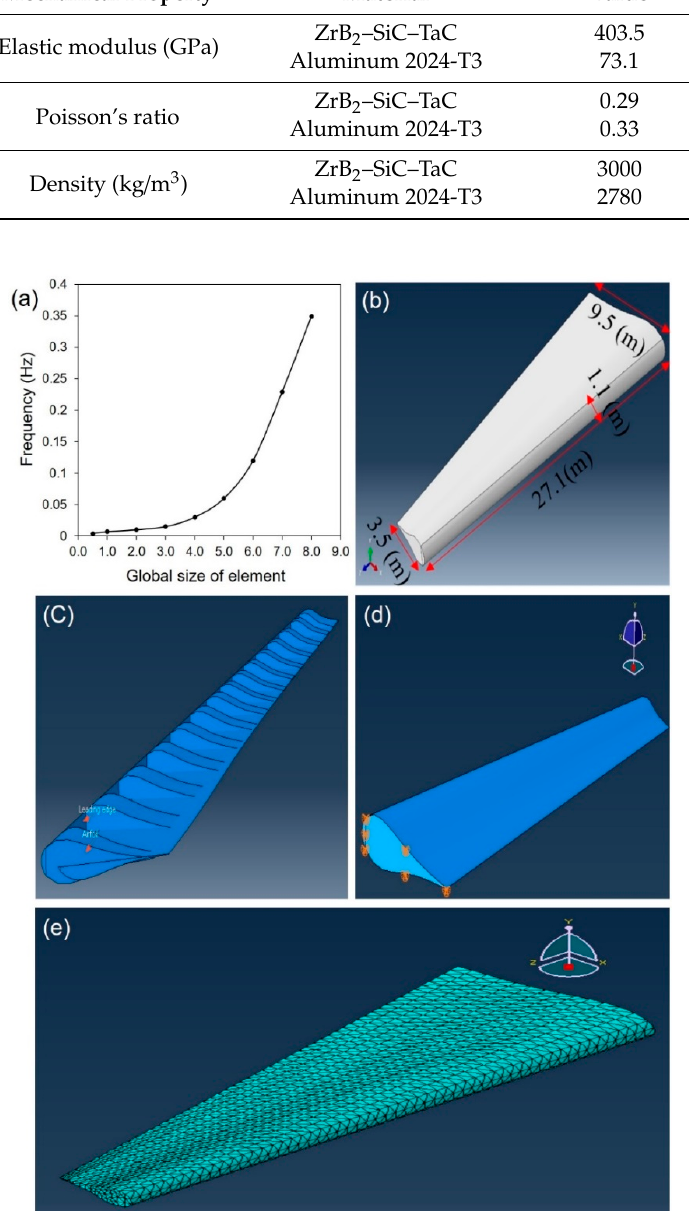
Figure 2. The mesh size evaluation and model of the aircraft wing in ABAQUS: ( a ) convergence study evaluating the appropriate mesh size for the wing, ( b ) wing dimensions, ( c ) internal view of wing showing the inside construction, and ( d ) clamped boundary conditions applied on the wing end, ( e ) meshed model.